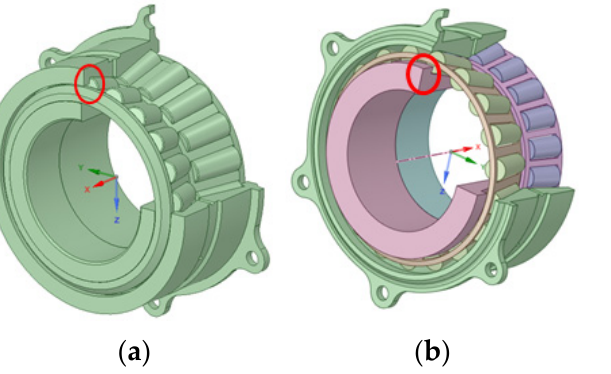
Figure 5. Double-row TBR models. ( a ) Outer ring rib structure; ( b ) Inner ring rib structure. Table 1. Main parameters of double-row